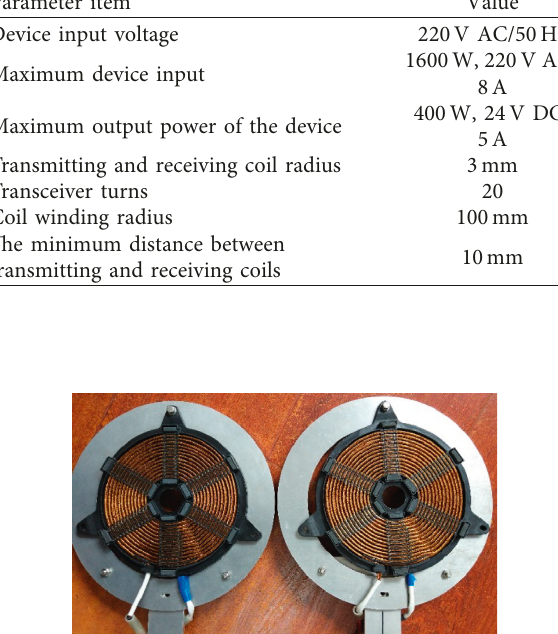
Figure 10: The maximum value of the magnetic field of the transmitting coil in transient field simulation.